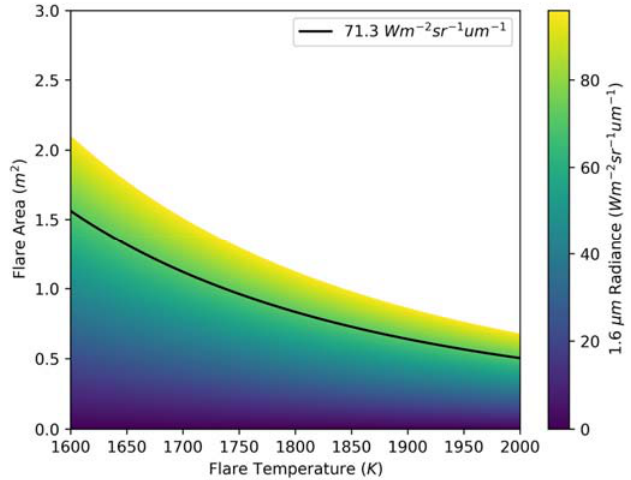
Figure A1. Modelled spectral radiances for high temperature events, calculated for a 1.6 µ m wavelength and for various hotspot effective temperatures and sub-pixel areas and assuming a pixel area of 900 m 2 representing the Landsat OLI sensor. The black line indicates the OLI 1.6 µ m channel nominal detector range (L MAX ) spectral radiance cut-off and L SAT cut-off is the interface between the white and coloured